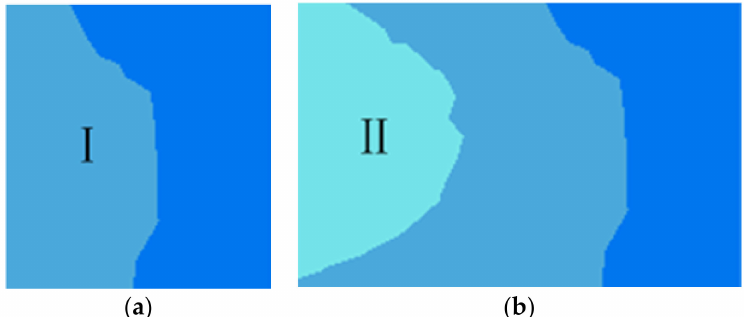
Figure 10. Contrast diagram of the significant color difference of water landscape. ( a ) indicates that there is no significant difference between the I regions and the sea water, ( b ) indicates that there is a significant difference between the 2 regions and the sea water.